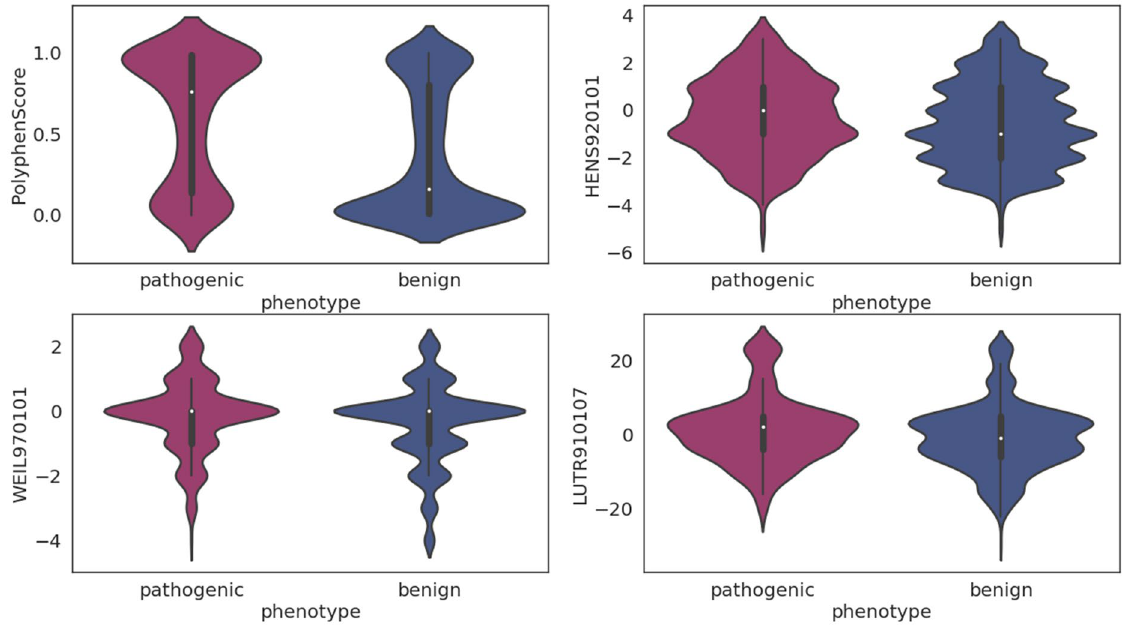
Figure 2. Distribution of the top discriminative features between the pathogenic and benign variants. Selected features incorporated sequence conservation and amino acids physicochemical properties. (PolyphenScore, HENS920101, WEIL970101 and LUTR910107). The selected features are significantly different between the two classes ( p < 0.001). Statistical significance was measured using the Welch sample